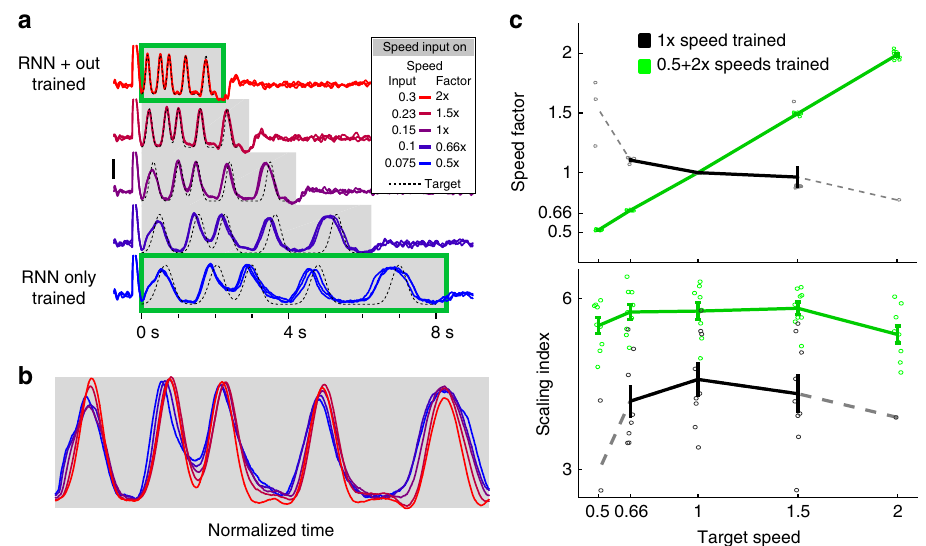
Fig. 3 RNNs trained at multiple speeds exhibit robust temporal scaling. a Output activity of an RNN trained to produce the scaled patterns of recurrent activity at 0.5× ( y SI = 0.075) and 2× ( y SI = 0.3) speeds. The output was trained only at the 2× speed. After training (weight modi fi cations stopped), the network was tested at different input speed levels ( y SI = [0.075,0.1,0.15,0.23,0.3]) — corresponding to speeds of 0.5, 0.66, 1, 1.5, and 2×. Three example test trials at each speed are overlaid. b One trial from each test speed above shown with time normalized to the end of the active period. c Networks ( n = 10) trained at two speeds generalize to untrained speed inputs. Top: The speed factor (the mean ratio of the fi nal tap at each speed to the mean fi nal tap time at 1× speed over 20 trials) of networks trained at two speeds (green), and one speed (black). Bottom: The scaling index of networks trained on two speeds is higher than those trained on one speed. Error bars represent SEM ( N = 10), and circles show the value for each network. Because the activity of the one-speed networks degrades at more extreme speeds as shown in Fig. 1, many networks did not produce detectable taps (output peaks) at extreme speeds and we, therefore, could not calculate a scaling index or index for them. We show in dotted lines the values for the networks that completed at least one trial at the extreme on three speeds (0.5×, 1×, and 2×) across 3 days. Analysis of the effect of speed (Supplementary Fig. 8, F 2,28 = 11, p < 0.0005, two- ( F 2,28 = 7.1, p < 0.005), and no signi fi cant interaction between